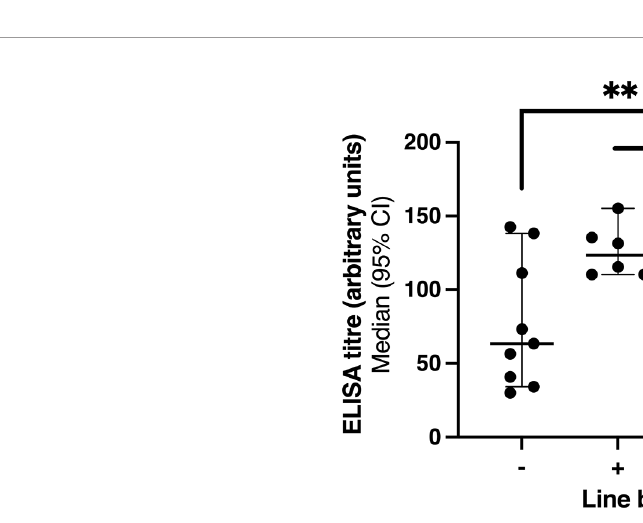
FIGURE 1 | TIF1 g ELISA values for 68 healthy controls and 42 TIF1 g serum